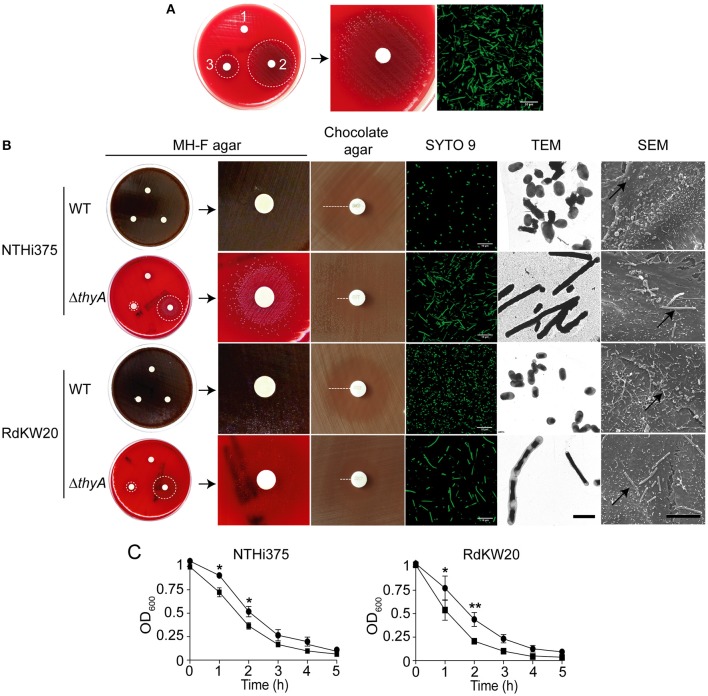
Thymidine auxotrophy modifies H. influenzae growth and morphology. (A) Growth of clinical isolate NTHi8233 on MH-F agar with sterile discs soaked in water (1), thymidine 10 mg/ml, thymidine 300 μg/ml (3). Dotted circles indicate the growth zone around discs (left). A zoom of bacterial growth around a disc soaked in thymidine 10 mg/ml is shown (middle). NTHi8233 morphology observed by SYTO 9 staining and confocal microscopy (scale bar, 10 μm; right). (B) Growth of NTHi375 and RdKW20 WT and ΔthyA strains on MH-F agar with sterile discs soaked in water (1), thymidine 10 mg/ml (2), thymidine 300 μg/ml (3). Bacterial growth rendering a lawn switches color of the MH-F agar medium from red to brown. Dotted circles indicate the growth zone around thymidine discs; zooms of bacterial growth around a disc soaked in thymidine 10 mg/ml are shown. Growth inhibition of NTHi375 and RdKW20 WT and ΔthyA strains on chocolate agar around TxS discs; dotted lanes indicate growth inhibition. Bacterial morphology observed by SYTO 9 staining and confocal microscopy (scale bar, 10 μm), TEM (scale bar, 2 μm; magnification 25000×), and SEM (scale bar, 10 μm; magnification 6000×). In SEM panels, black arrows indicate infecting bacteria. (C) Effect of thymidine auxotrophy on H. influenzae self-aggregation. Tube-settling experiment of bacterial cultures previously grown for 11 h on sBHI, after incubation at room temperature for 5 h. Left, NTHi375 WT and ΔthyA strains; right, RdKW20 WT and ΔthyA strains; WT strains, black circle; ΔthyA mutants, black square. Bacterial aggregation was quantified by measuring the decrease of absorbance at OD600. The thyA mutants self-aggregated faster than their isogenic WT strains (for NTHi375, p < 0.05 at 1 and 2 h; for RdKW20, p < 0.05 at 1 h, and p < 0.0005 at 2 h). All significant differences are indicated with *.